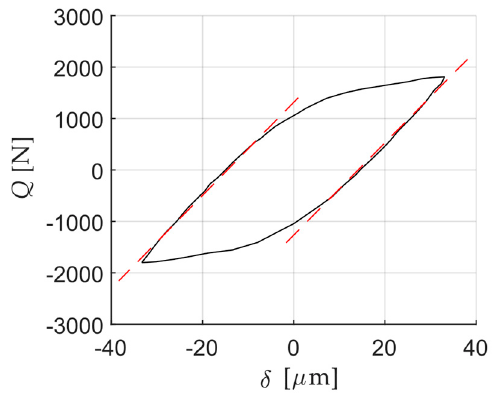
Figure 11. Fretting loop (black continuous line) and curve linearization of both micro-slip regimes (dashed red line) for the fretting loop of Arnaud et al. [10] . Table 2. Summary of the total tangential stiffness of different fretting tests found in the literature. Ref.